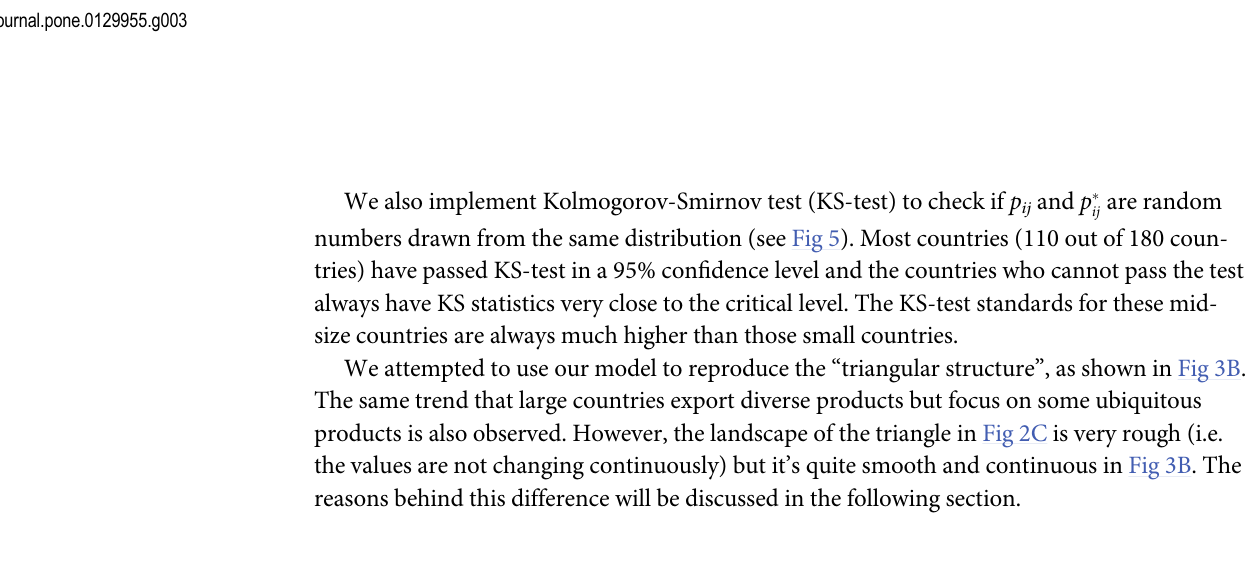
Fig 3. (A) Comparisons between the theoretical and the empirical p ij for four selected countries. (B) The simulated “ triangular structure ” from Eqs (5) and (6); the colors represent ln p ij